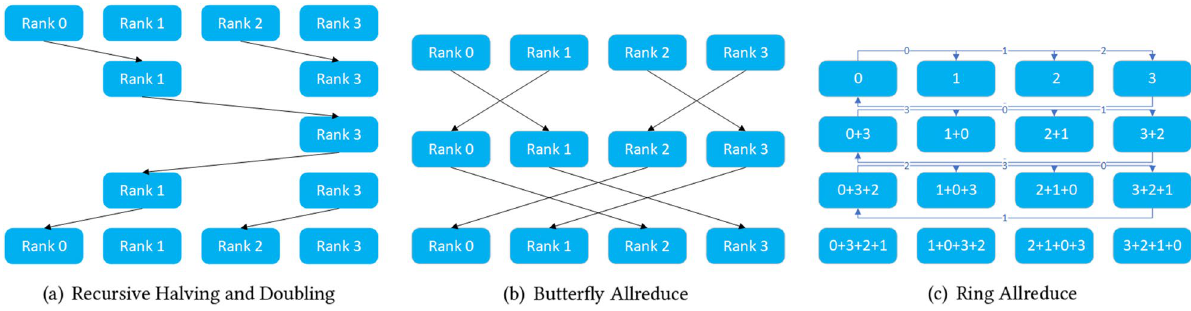
Figure 5. Recursive halving and doubling, butterfly and ring